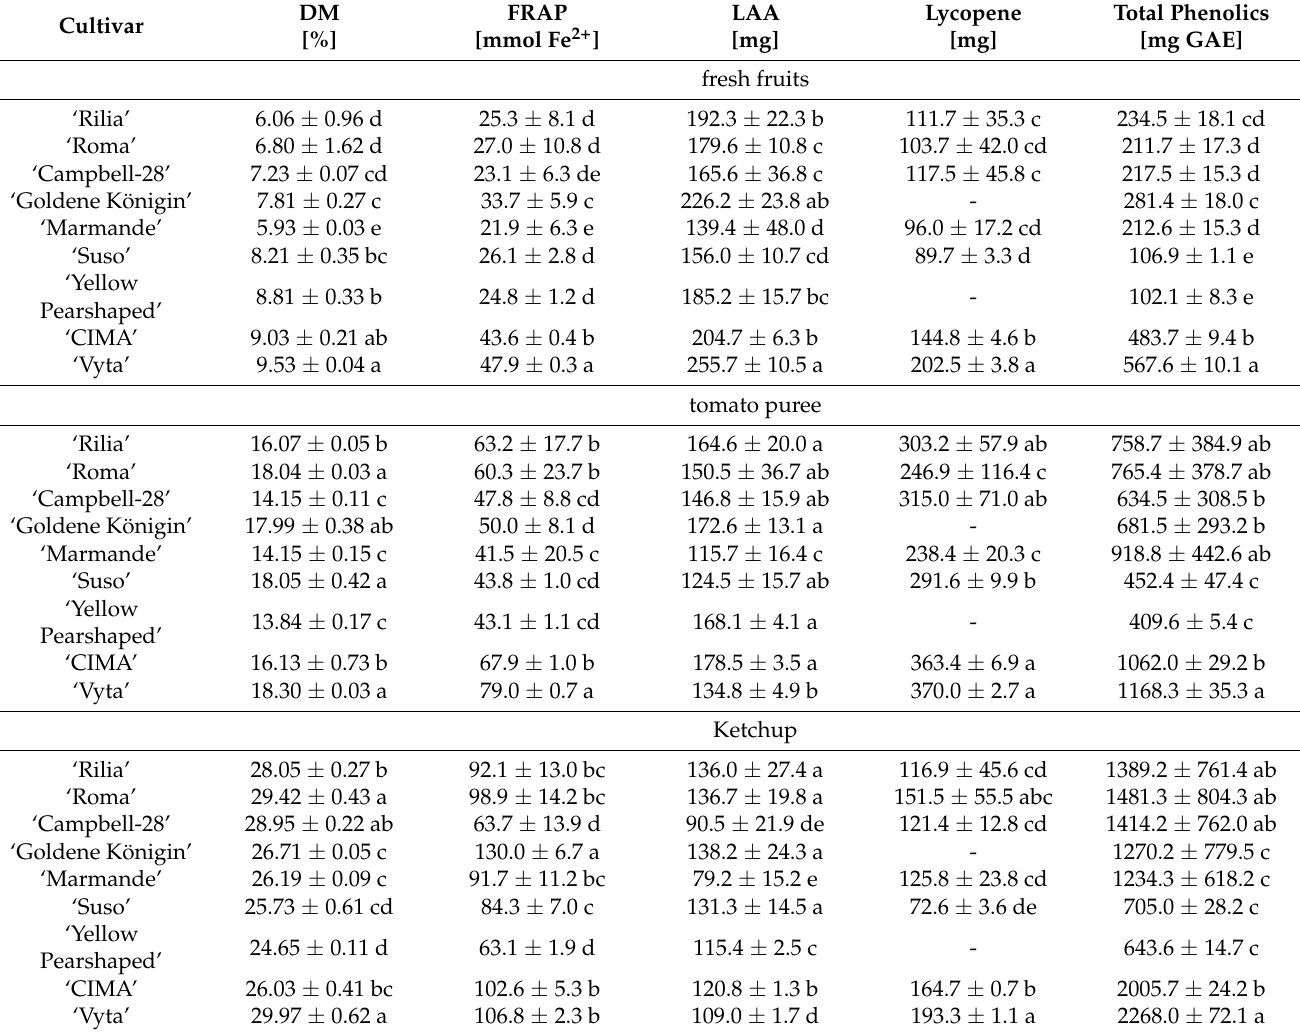
Table 1. Dry-matter content and antioxidant properties of different tomato cultivars as a function of processing type. Data are expressed per 1 kg of fresh mass (FM) or in % of